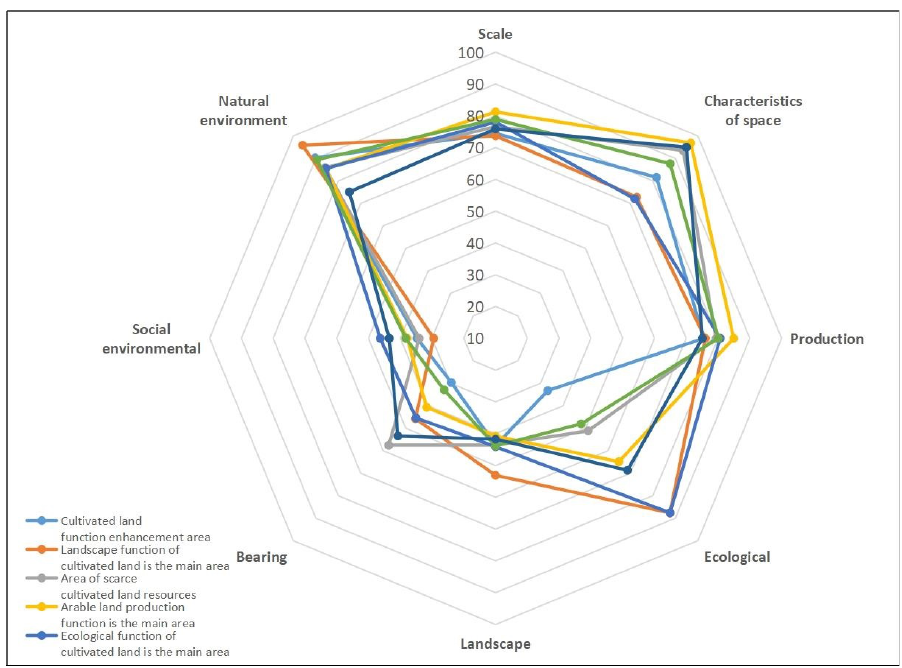
Figure 8. Comprehensive quality of cultivated land in various types of districts in Qujiang District.